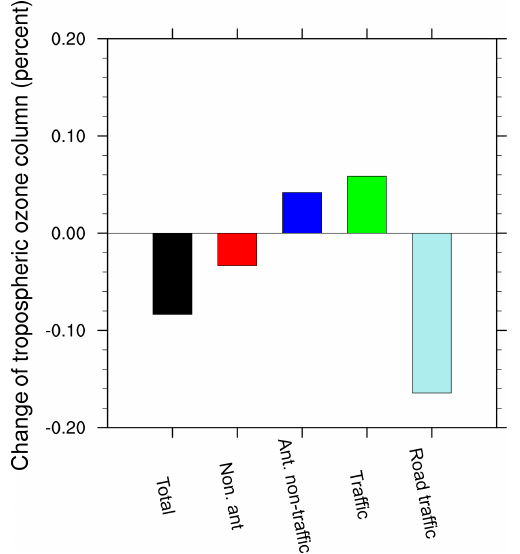
Figure 11. Changes in the global tropospheric ozone budget [%] resulting from a 5% reduction in the road traffic